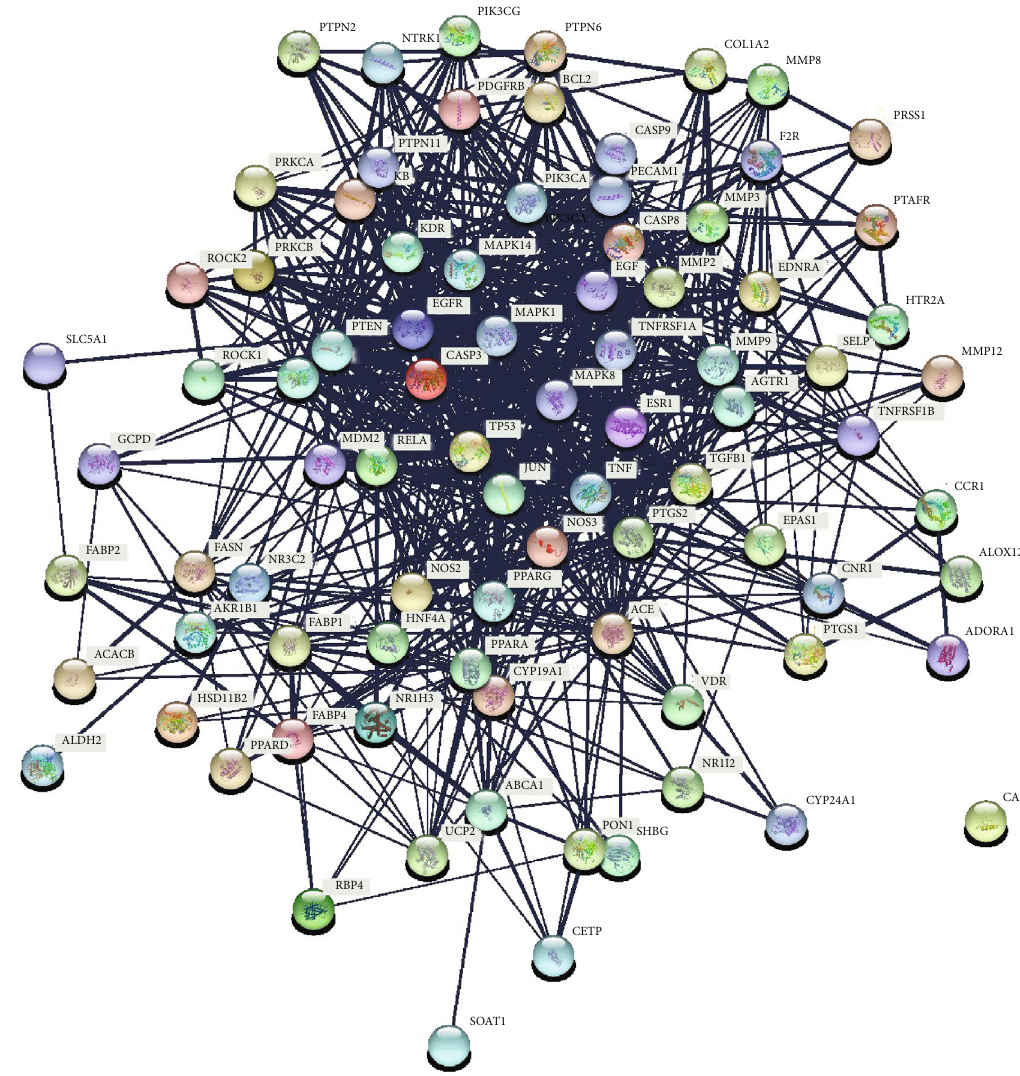
Figure 4: PPI network of overlapping targets between DN and Cordyceps. Each circular node represents a protein target, and the 3D structure in the circular nodes shows the protein spatial structure. The lines among di ff erent nodes represent the association among potential protein targets, while the width of lines was according to the action